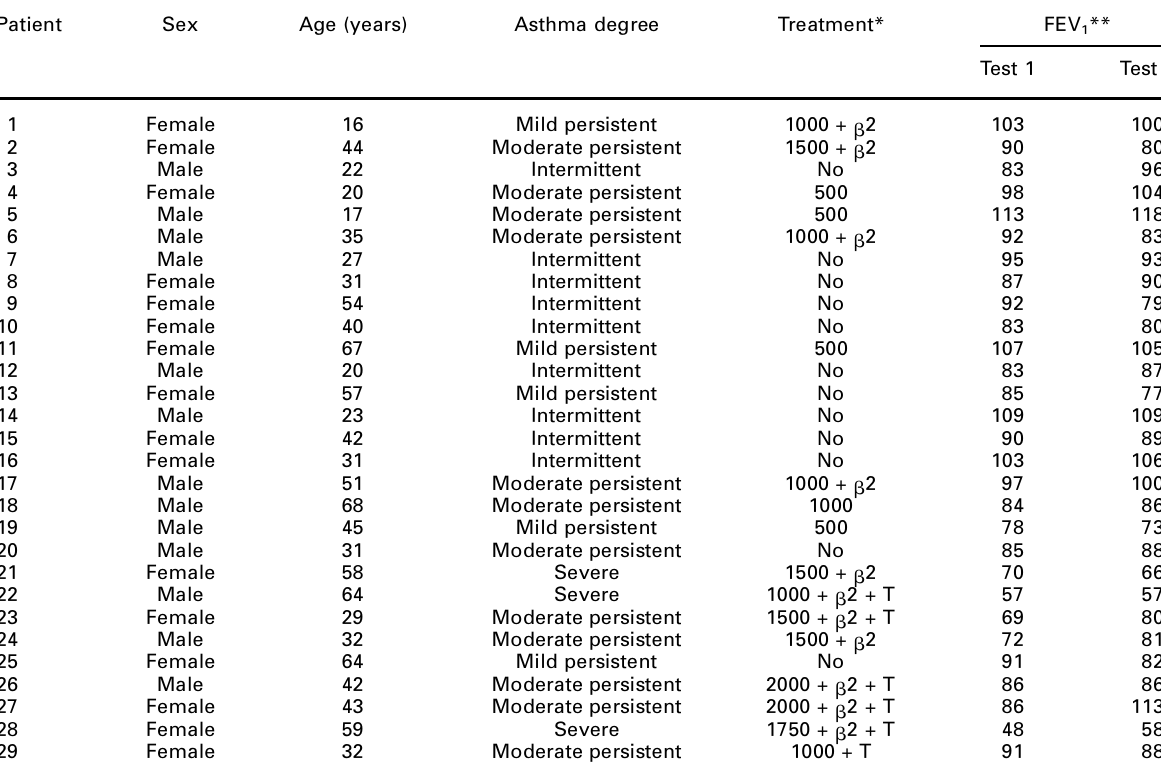
Table 1. Clinical characteristics of asthmatic subjects Patient